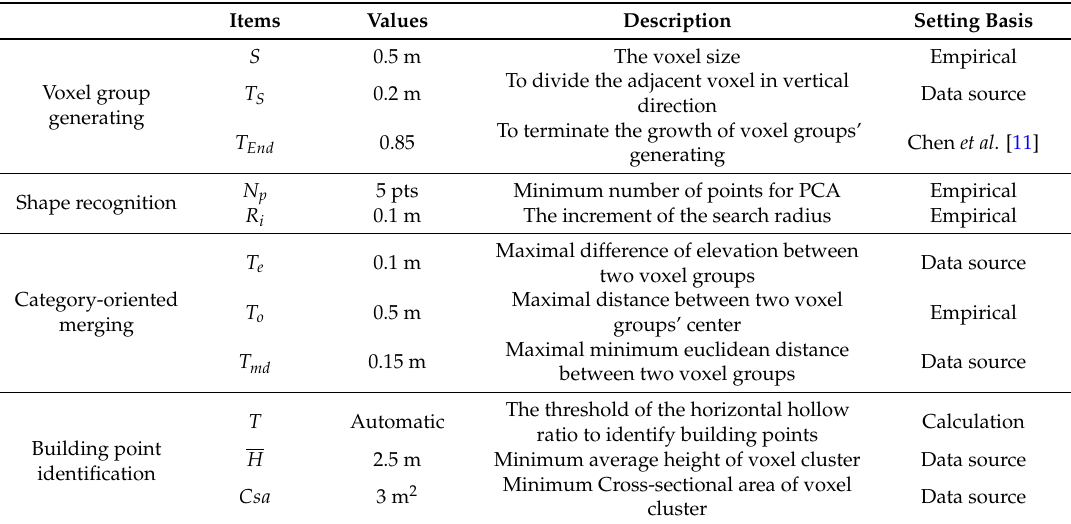
Table 2. The key thresholds and parameters of the proposed